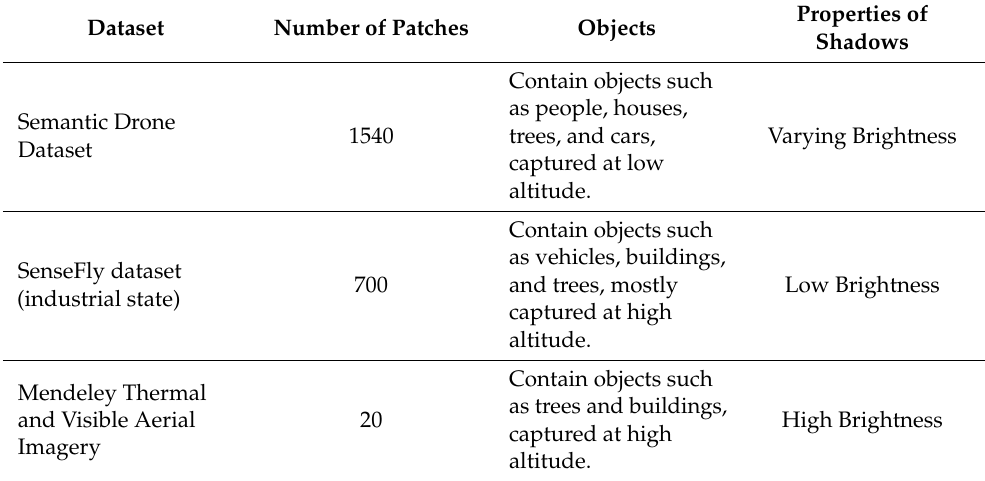
Table 1. Description of dataset.